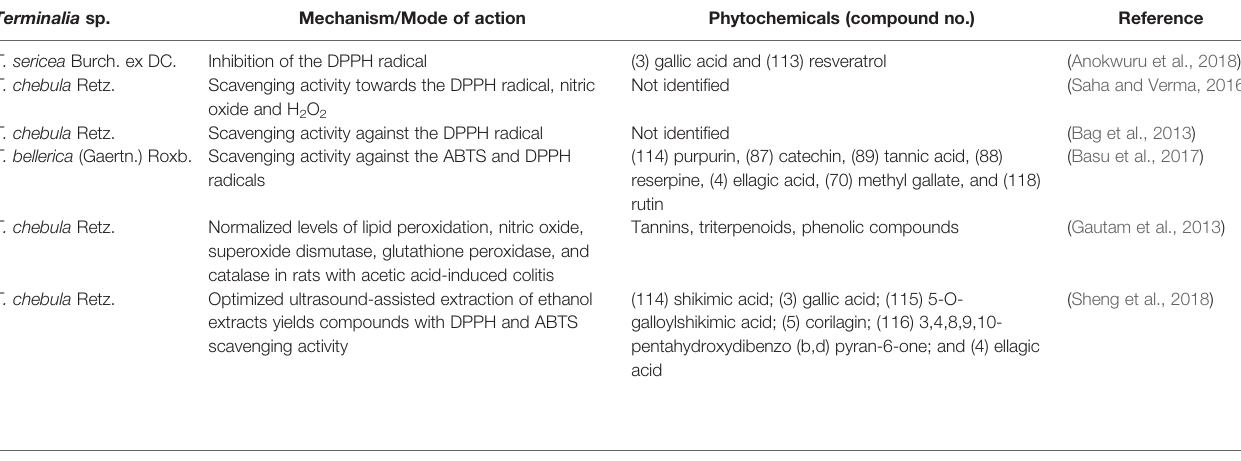
TABLE 6 | Summarization of the antioxidant studies of different Terminalia species. Terminalia